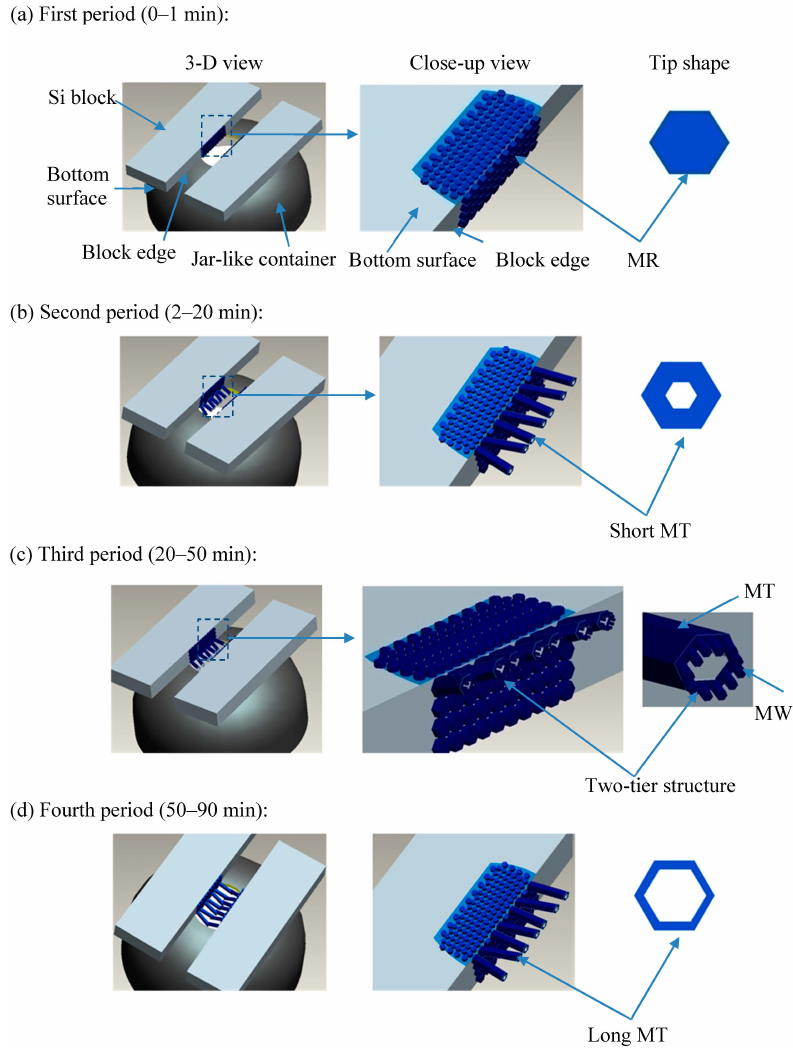
Figure 3. Schematics of synthesized products in the four periods. Many rows of MTs are produced during the growth process, while only a row of them is shown in each set of drawings for illustration purpose. ( a ) First; ( b ) second; ( c ) third; ( d ) fourth